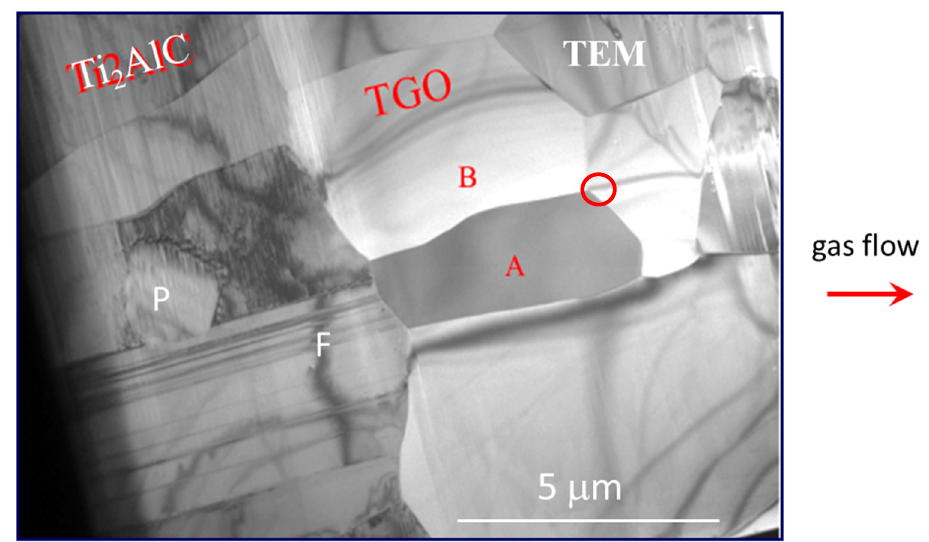
Figure 11. FIB section II: TEM image of the backside of the burner sample. Clean, intact Ti 2 AlC—Al 2 O 3 interface. Columnar TGO grains at the interface and equiaxed at gas side; planar faults (F) and included Al 2 O 3 particle (P) in Ti 2 AlC (500 h at 1216 °C).